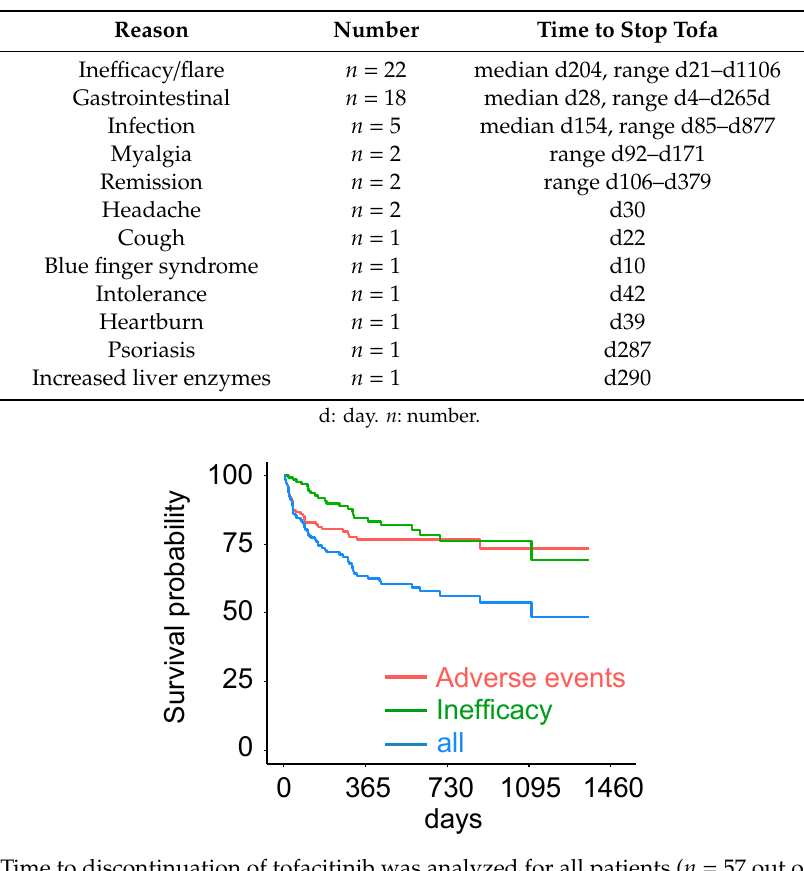
Table 2. Reasons for stopping tofacitinib.